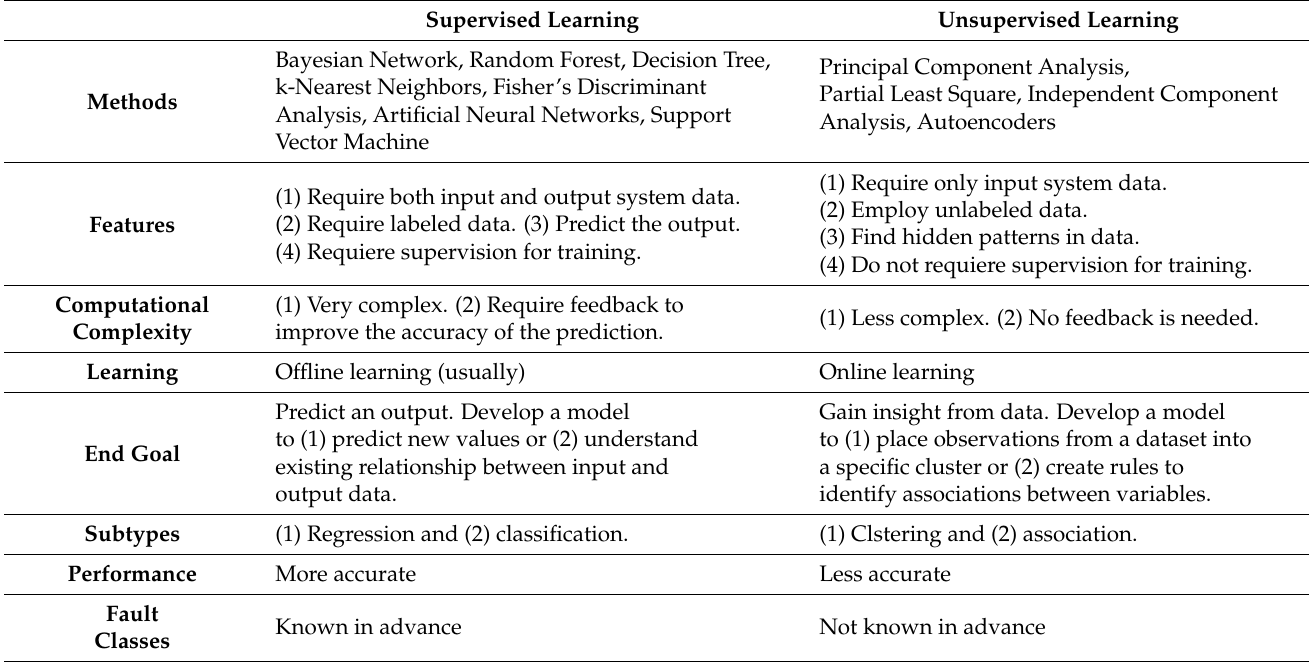
Table 4. Comparison between supervised and unsupervised learning